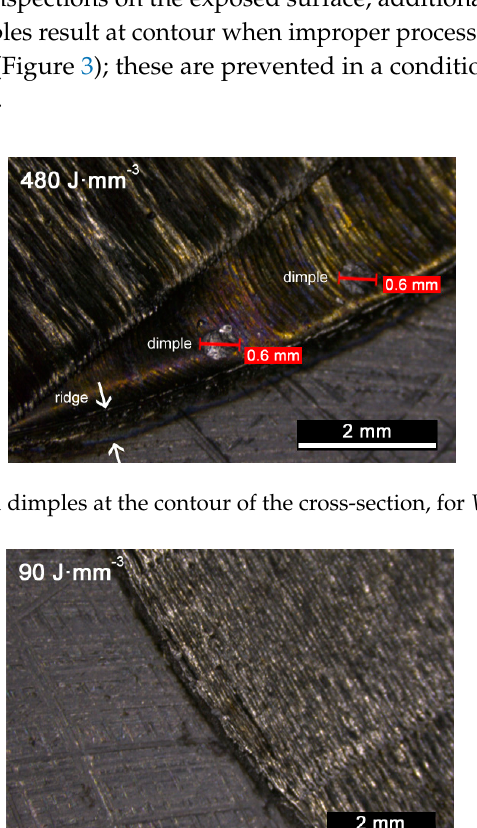
Figure 4. Contour of the cross ‐ section for VED of 90 J ∙ mm − 3 .